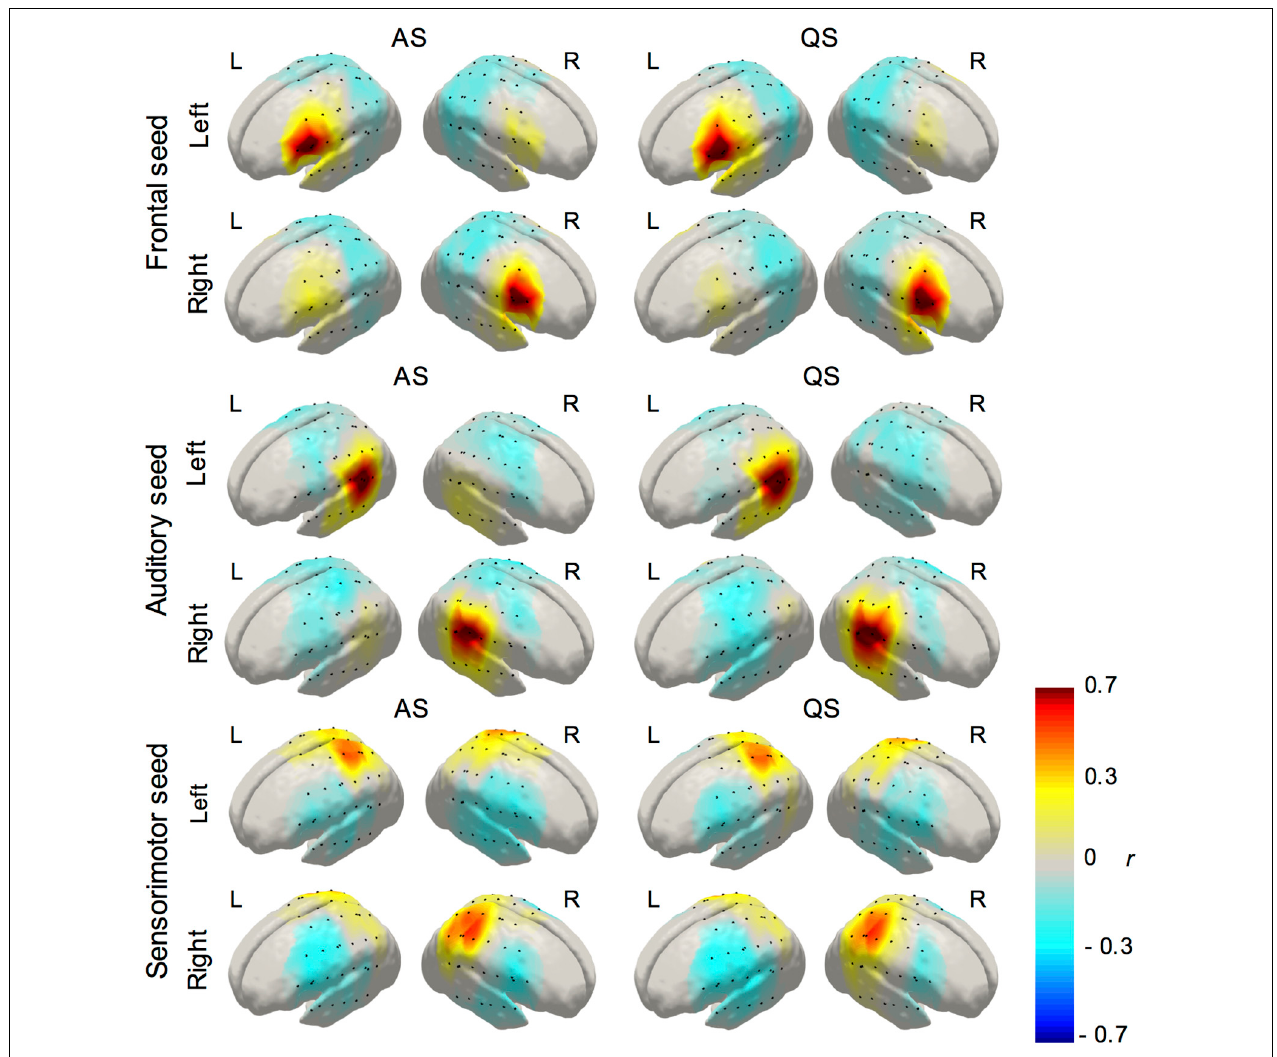
FIGURE 3 | Average correlation maps (HbO) derived from the seed-based correlation method for the left and right seeds in the inferior frontal, auditory, and sensorimotor regions (AS, active sleep, first column; QS, quiet sleep, second column). Due to its high similarity, and to avoid presenting redundant information, HbO maps are displayed in the main text and HbR maps are presented as Supplementary Material